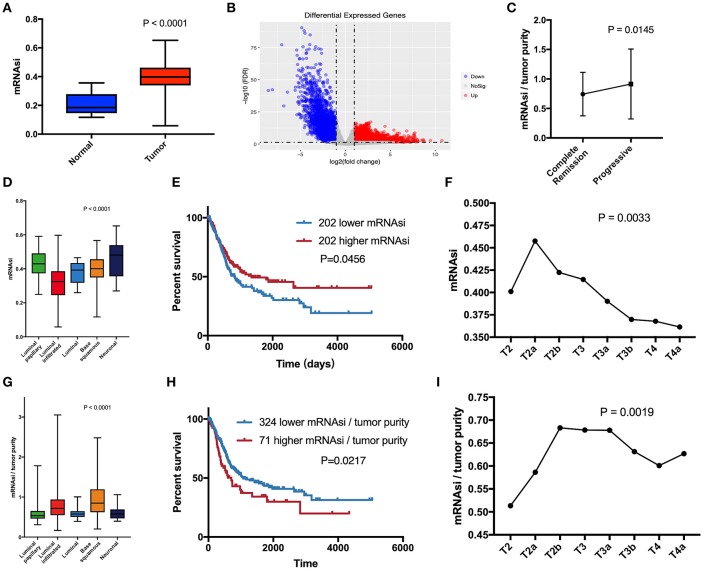
(A) Differences in mRNAsi between normal (19 samples) and tumor (404 samples) tissues. (B) Differentially expressed genes; blue indicates down-regulated of genes, and red indicates up-regulated of genes. (C) After primary treatment, the progression group had a higher corrected mRNAsi (mRNAsi/tumor purity) than the complete remission group. (D) Comparison of mRNAsi in five MIBC molecular subtypes. (E) Kaplan-Meier curves show that the low mRNAsi group had greater mortality than does the high mRNAsi group. (F) Excluding T1 and T4b with small sample size, mRNAsi generally decreases with bladder cancer progression. (G) Comparison of corrected mRNAsi in five MIBC molecular subtypes. (H) Kaplan–Meier curves show that the higher corrected mRNAsi group had greater mortality than that of the lower mRNAsi group. (I) Corrected mRNAsi generally increases from located to advanced.